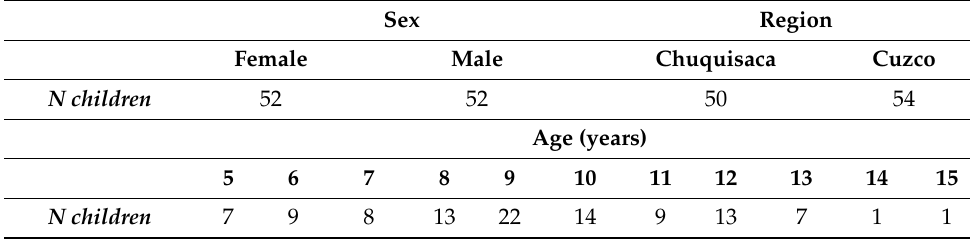
Table 3. Demographic characteristics of